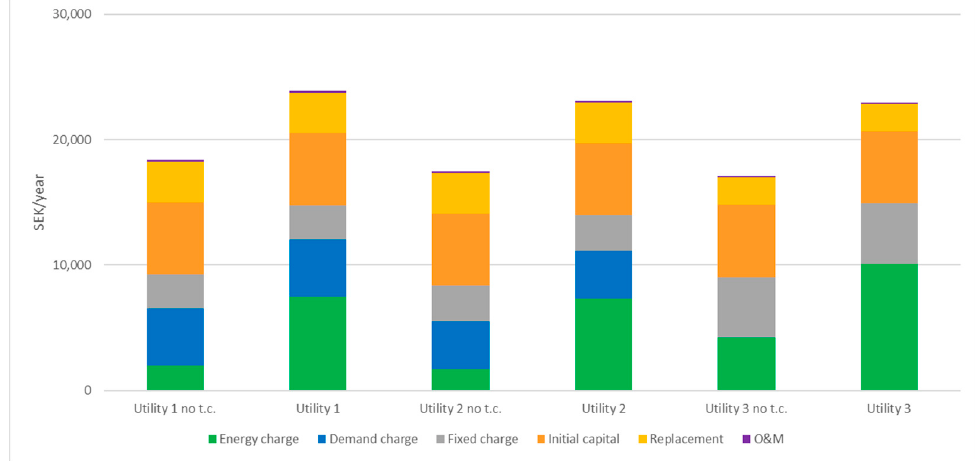
Figure 9. Impact of tax credit on annual costs.